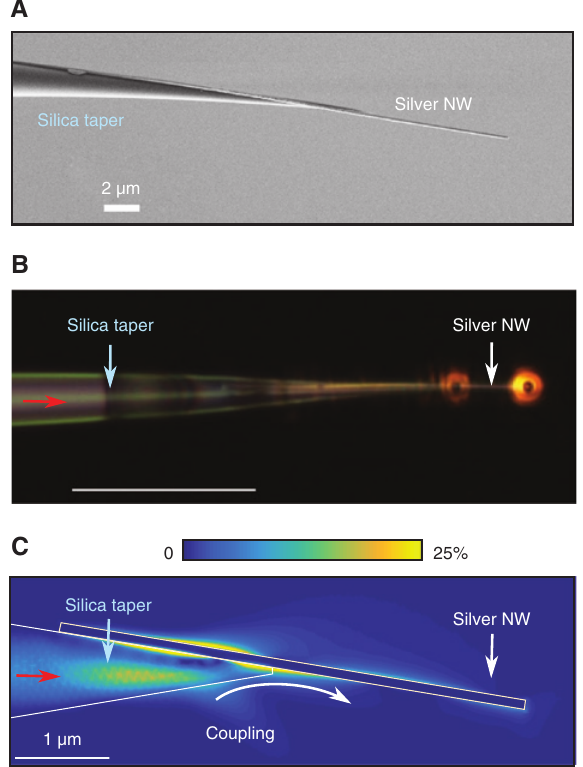
Figure 9: Silver nanowire integrated onto the end-face of a tapered